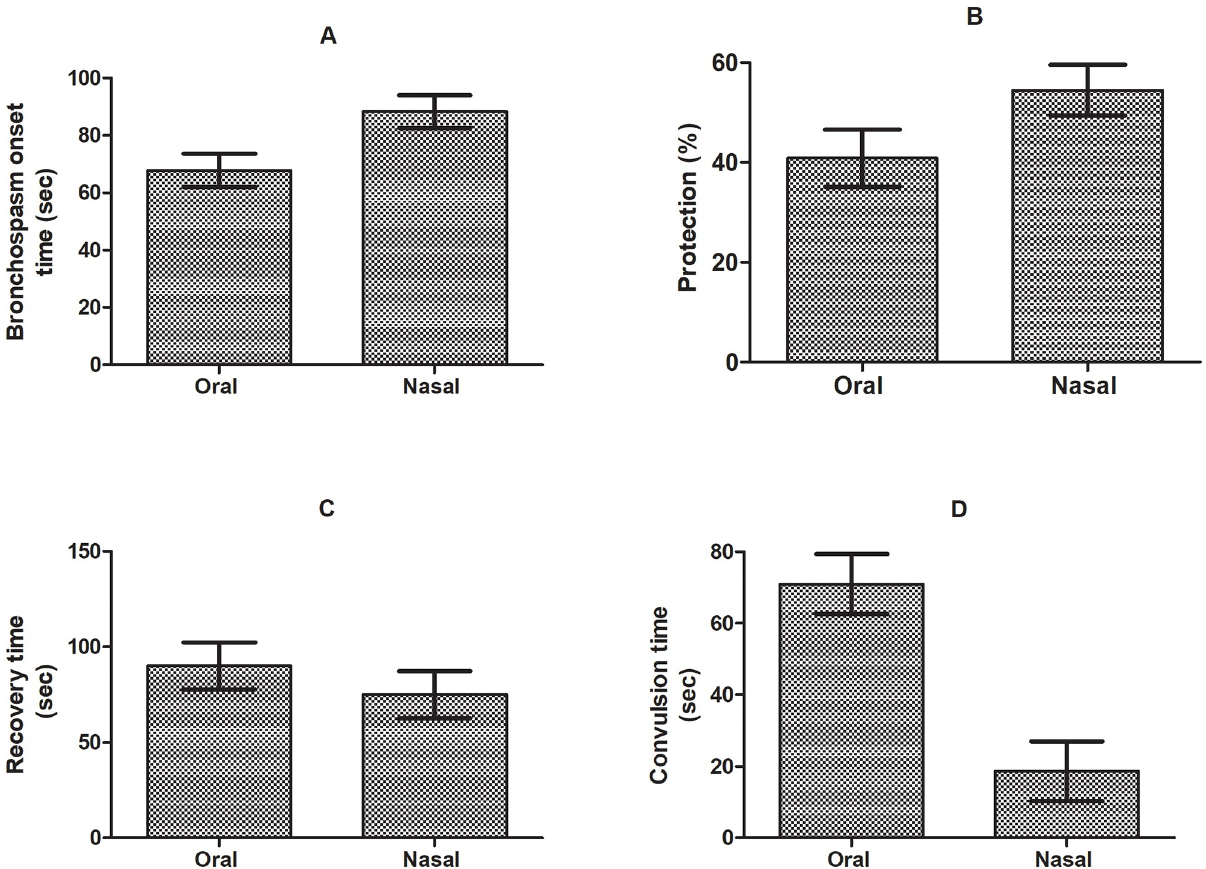
Fig 4. Effect of oral and nasal treatment on (A) bronchospasm onset time, (B) percentage protection, (C) recovery time and (D) convulsion time respectively in ovalbumin induced asthma model.